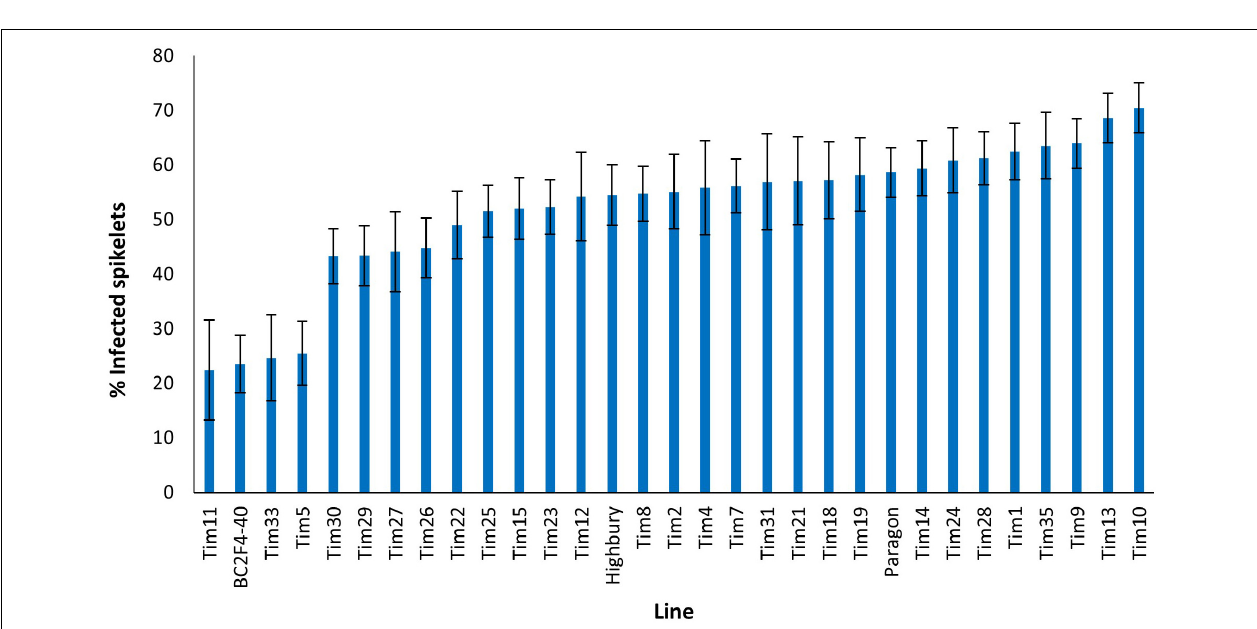
FIGURE 6 | Visual FHB disease score from 2021 trial of 29 T. timopheevii accession P95-99.1-1/wheat introgression lines, Highbury and Paragon susceptible controls expressed as percentage of infected spikelets 21 days post spray inoculation with F. culmorum (1 × 10 5 conidia per ml).